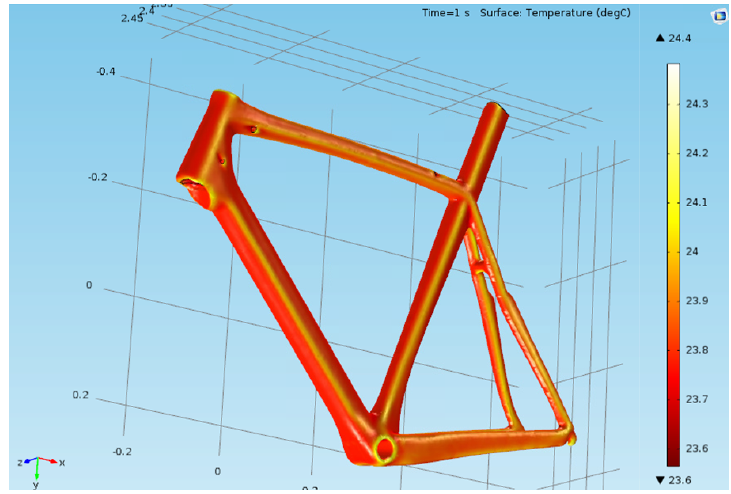
Figure 8. Numerical finite element model result after 1 s. Temperatures in ◦